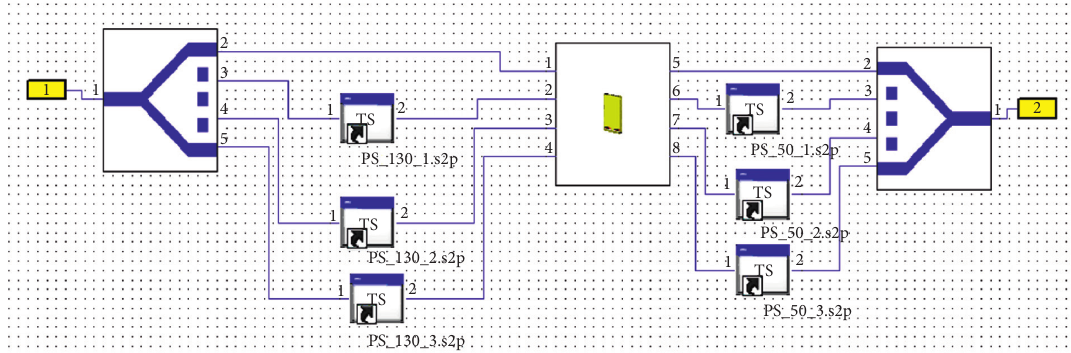
Figure 19: CSTschematic view of the circuitry used for obtaining the array coupling values between the two UE’s MBS arrays. Each yellow box is a single port representing one of the 4-element arrays. The squares are the phase shifts applied to each antenna of the array for a particular ψ m .